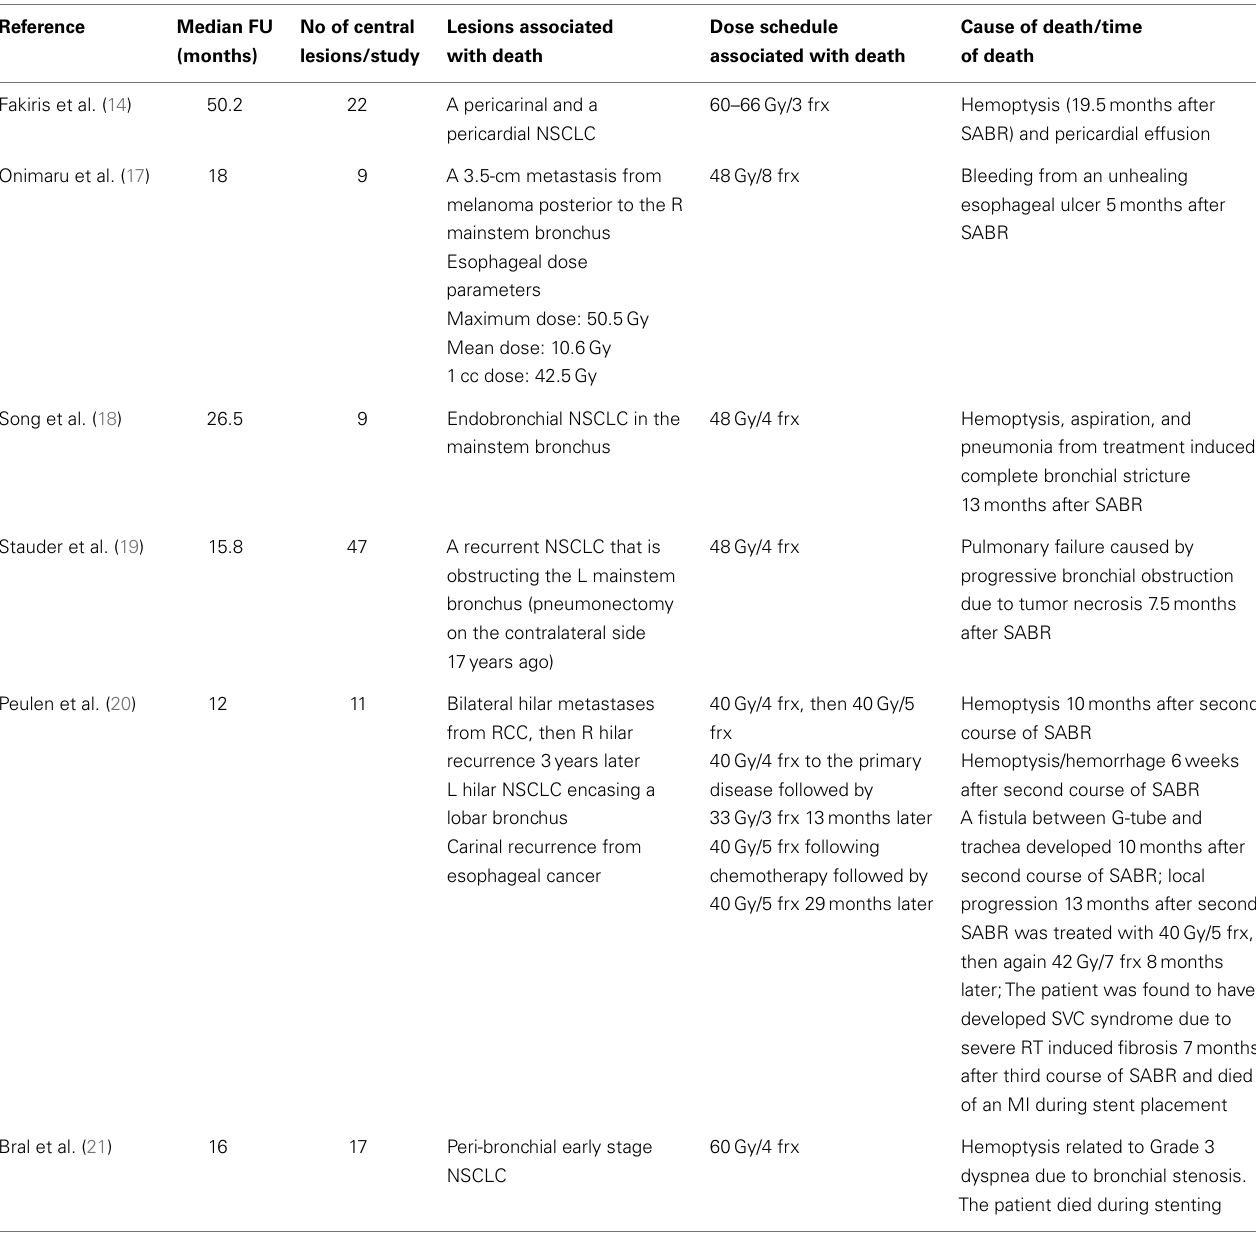
Table 2 | Deaths following SABR for central lung tumors in studies including both peripheral and central lesions